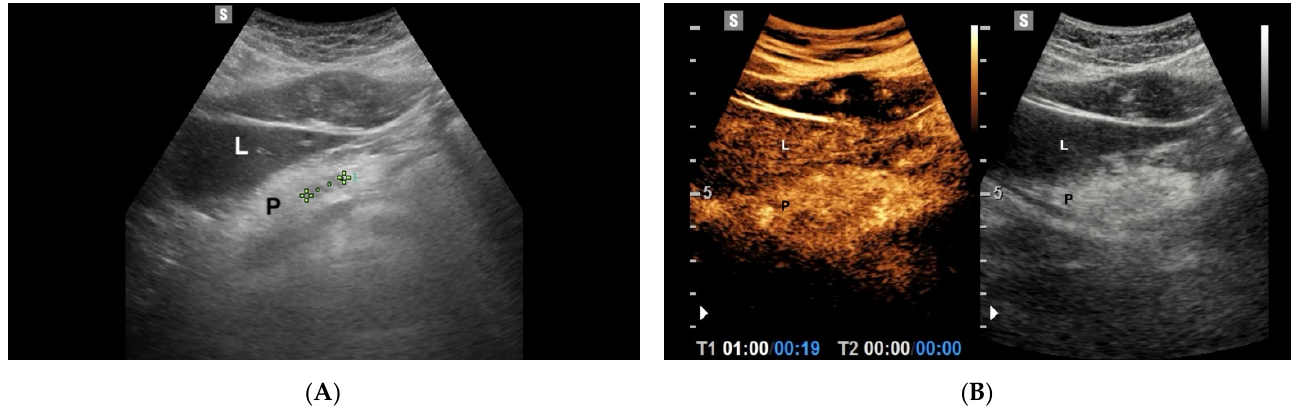
Figure 4. Focal autoimmune pancreatitis. ( A ) B mode Ultrasonography shows a 1.2 cm hypoechoic lesion (calipers) in the pancreatic body; (L: liver; P: Pancreas). ( B ) On CEUS, in the arterial phase (19 s after the injection of c.a.), the lesion is isoechoic in comparison with the adjacent pancreatic parenchyma.